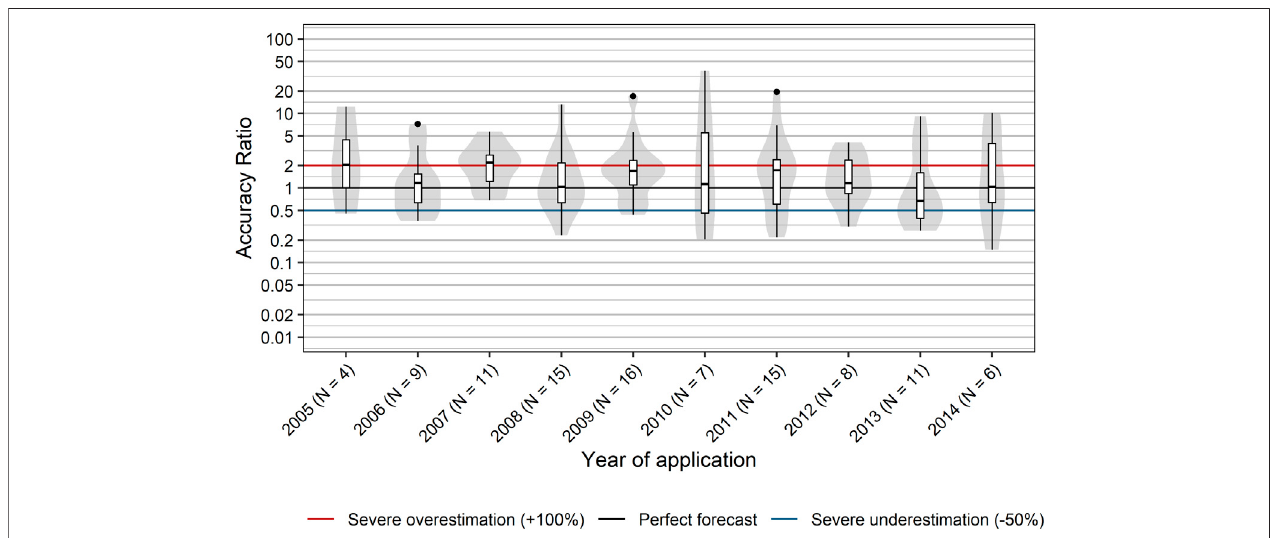
FIGURE8 | Accuracy ofsales forecasts over time.Box plots and violinplots show accuracyratios offorecasted sales inthe 3 years after apositivereimbursement decision, grouped by year of application. Due to their asymmetric nature, accuracy ratios are plotted on a logarithmic (base 10) scale to avoid visually overemphasizing overestimates compared to